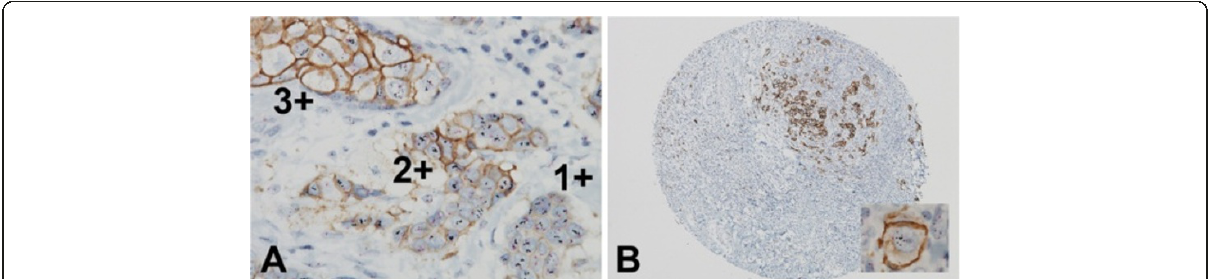
Figure 5 Results of HER2 gene-protein staining of FFPE breast cancer tissues exhibiting heterogeneity of HER2 positive tumor cell populations or isolated tumor cell populations. ( A ) The HER2 gene-protein assay demonstrated the heterogeneity of HER2 positive tumor cell populations in FFPE breast cancer tissues. In the sample shown, cell populations with HER2 IHC scores of 3+, 2+, and 1+ neighbor each other and all tumor populations present amplified HER2 gene. However, the HER2 IHC 3+ tumor cell population contains dispersed HER2 gene copies while the HER2 IHC 2+ and 1+ population contains clustered HER2 gene copies [40×]. ( B ) The HER2 gene-protein assay clearly visualized small groups of HER2 IHC 3+ breast cancer cells [4×]. The insert shows an isolated individual HER2 IHC positive tumor cell with HER2 gene amplification [100×].